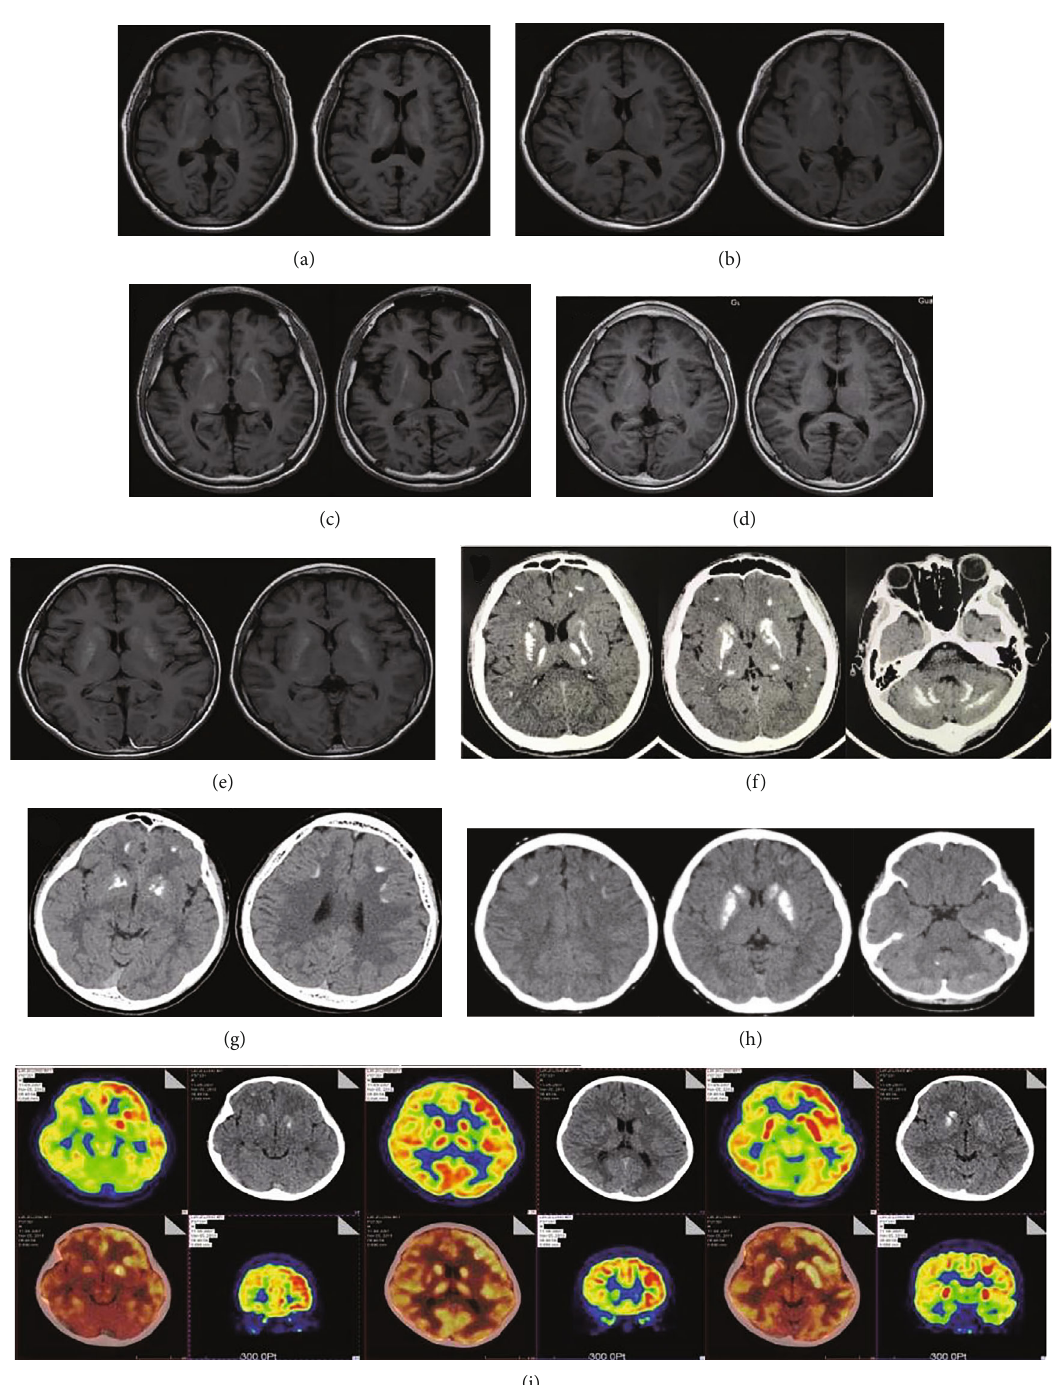
Figure 1: Representative imaging results of all patients. (a) – (e) Representative MR results of cases 1-5. (f) – (h) Representative CT results of cases 3-5. (i) Representative PET-CT results of case